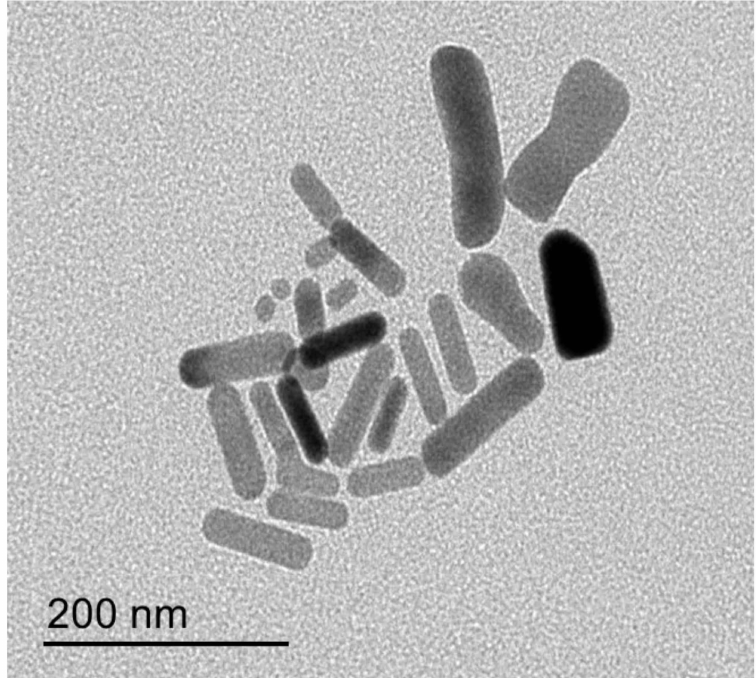
Figure 3. TEM image showing the morphology of rod